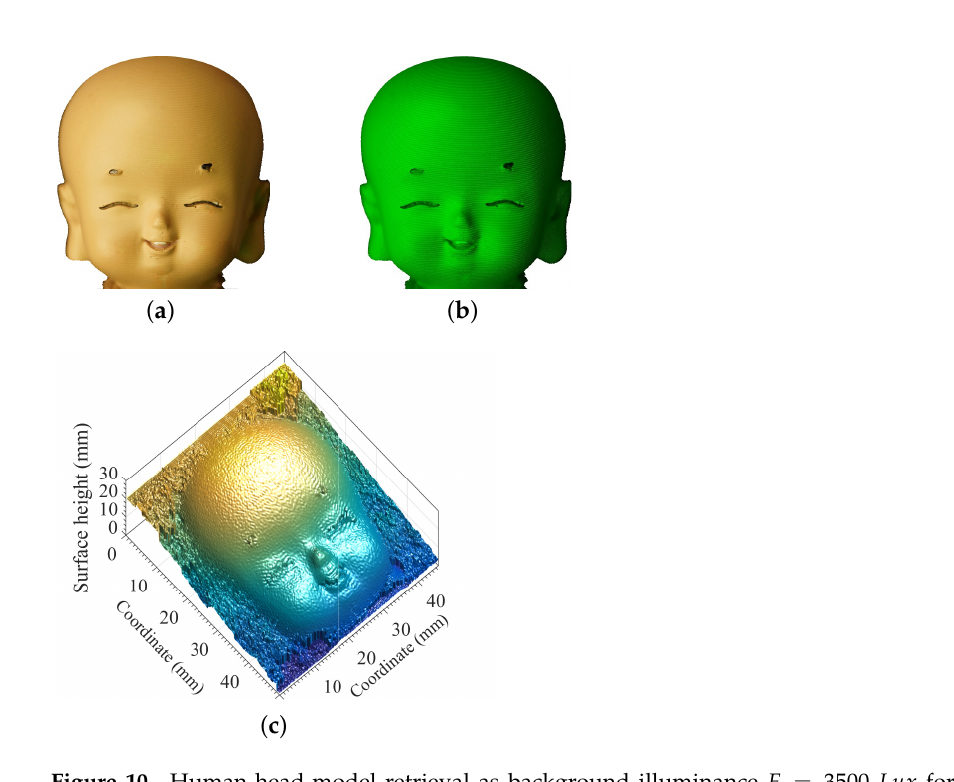
Figure 10. Human-head-model retrieval as background illuminance E = 3500 Lux for indoor measurement. ( a ) without filtering; ( b ) with filtering; ( c ) This is the retrieval using the measurement of ( b ), while it is unable to obtain satisfied retrieval using the measurement of ( a ).